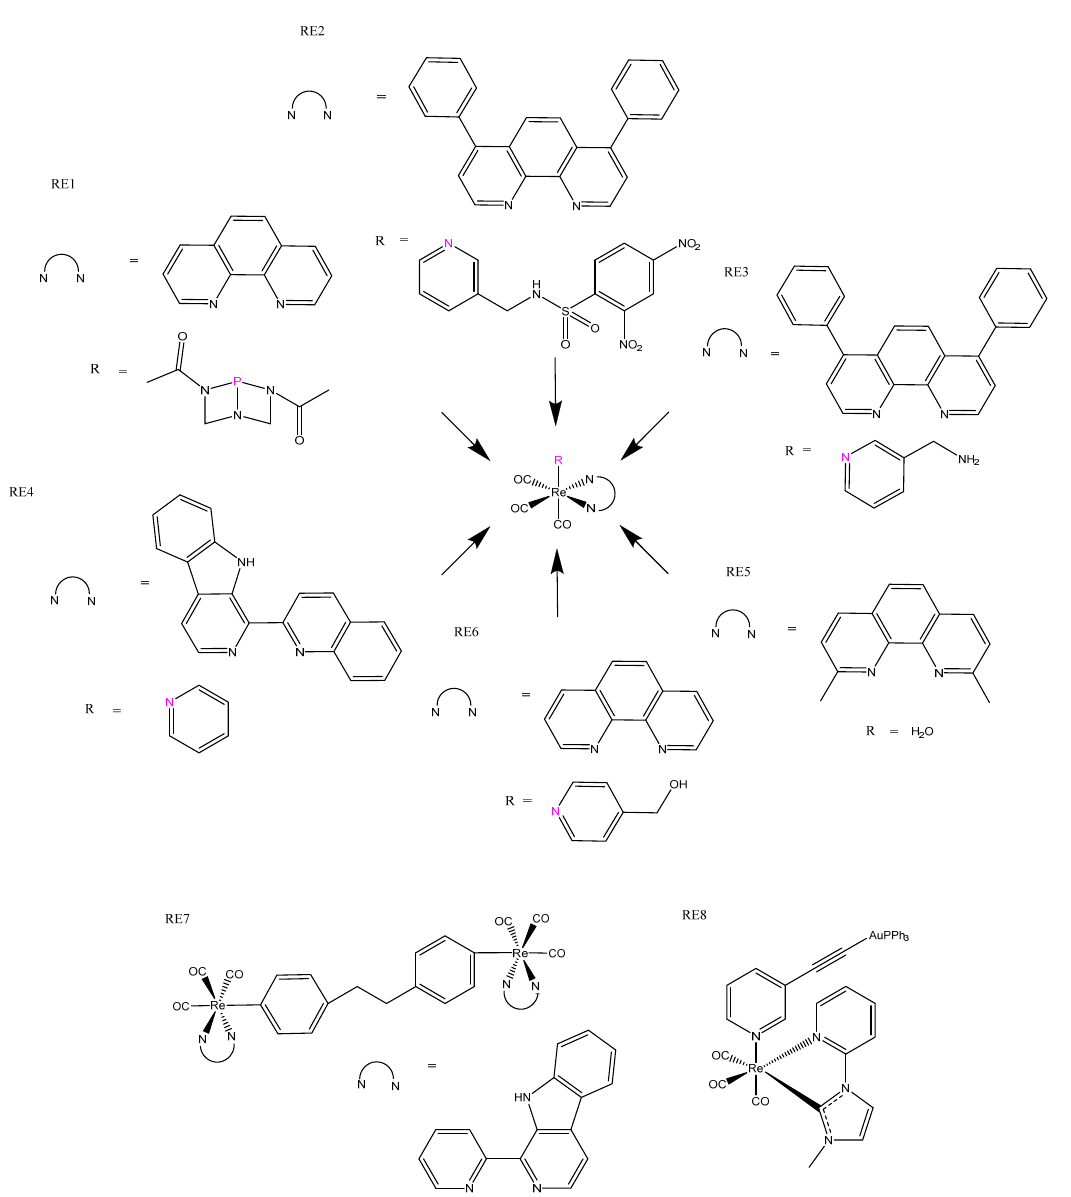
Figure 12. Rhenium(I) luminescent complexes: phosphine ligated complex RE1 [93], GHS-responsive bio-sensing complex RE2 [94], mitochondrial-targeted theragnostic complex RE3 [96], β -carboline rhenium complex RE4 [97], rhenium(I) aqua complex RE5 [98], apoptosis-ferroptosis dual-induction complex RE6 [99], heterodinuclear Re(I) β -carboline complexes RE7 [100], and gold(II)/rhenium(I) heterodinuclear complex RE6 [102].